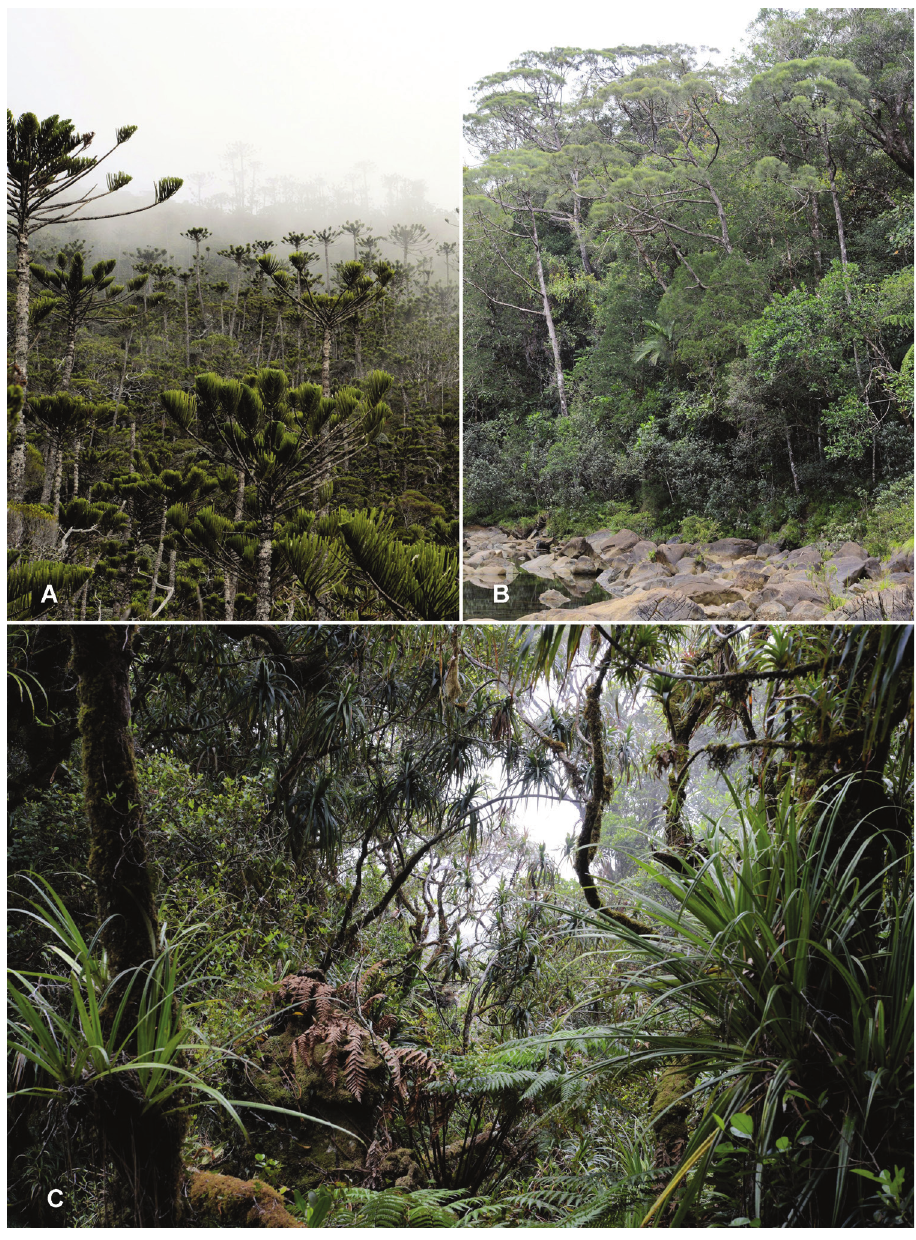
Figure 5. Habitat images from New Caledonia A Mont Humboldt Nature Reserve, site of K. macro- phylla , with Araucaria humboldtensis B Blue River Provincial Park, site of K. isidiata and K. macrophylla C Mont Mou Nature Reserve, holotype locality of K. macrophylla . Photo: J. Rikkinen. Additional specimens examined. New Caledonia. Province Sud : Blue River Provincial Park, dense riparian forest near camp site on river bank, on tree trunk, 22°05'54.79"S, 166°38'20.24"E, 200 m alt., 2016-09- 22, J. Rikkinen 35037